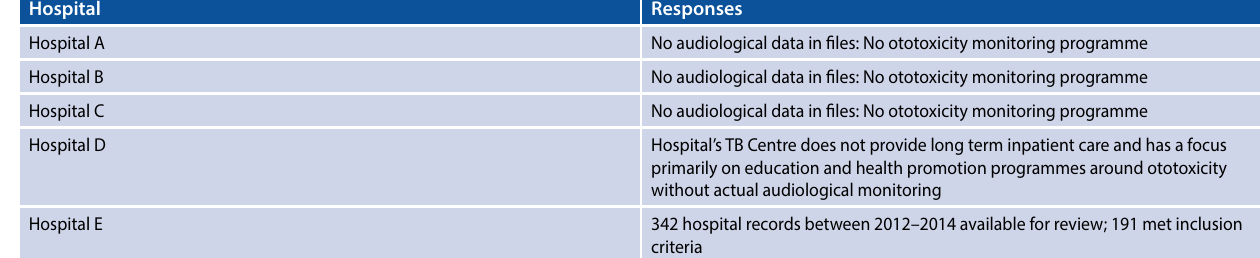
Table 1: Participating hospitals’ responses regarding ototoxicity programmes